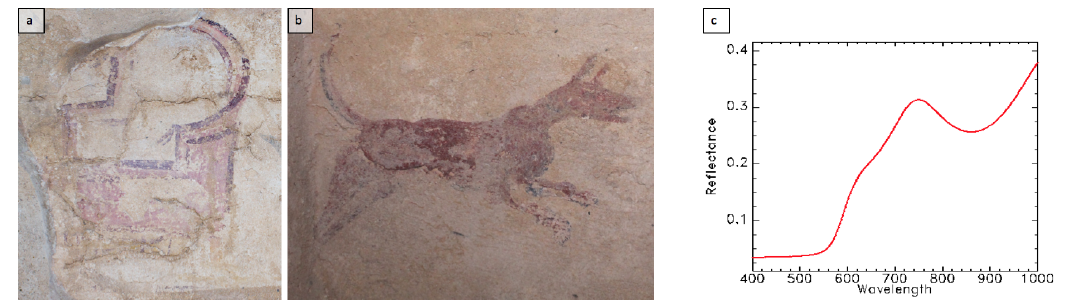
Figure 13. ( a ) Depiction of an arm chair featuring light and dark purple hues painted on the northern end of the dado of the central arcosolium in Tomb Roma 1 (J); ( b ) A red painted dog on the southern end of the dado of the arcosolium (J); ( c ) reflectance spectrum of